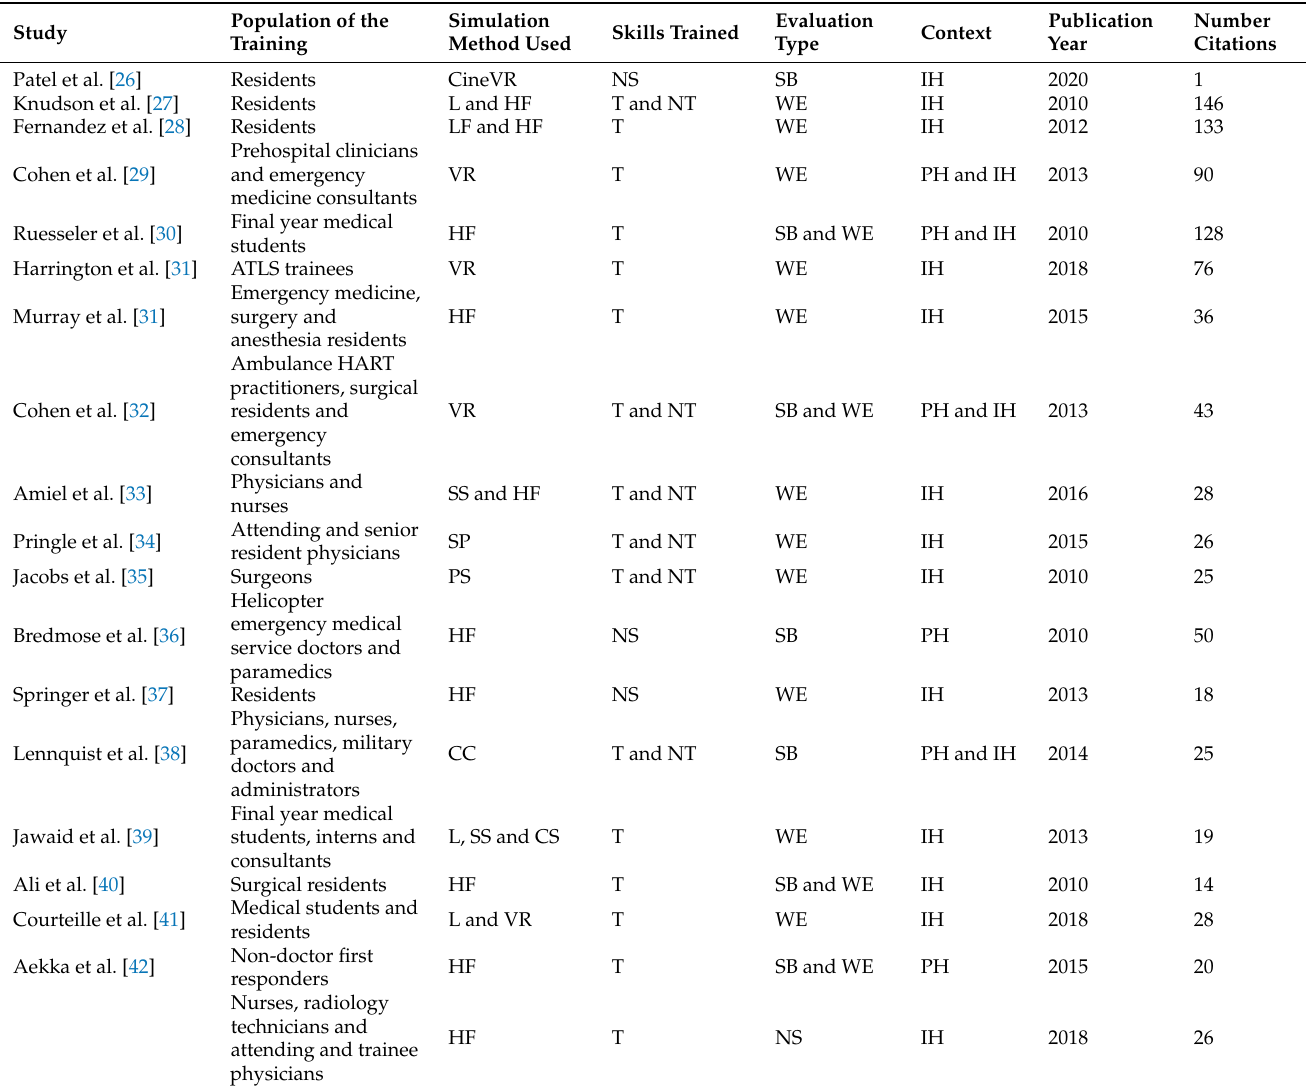
Table 1. Summary of the articles included in this scoping